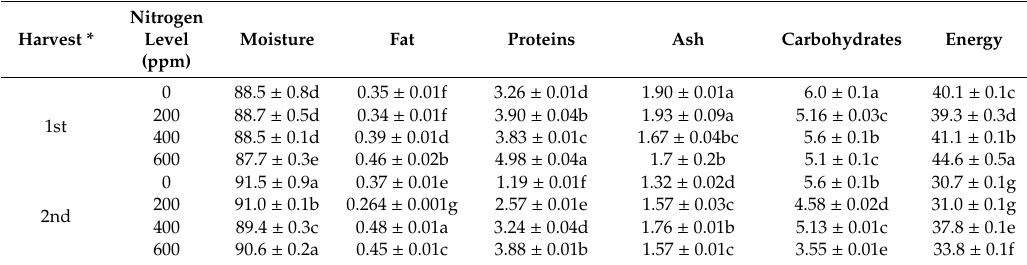
Table 2. Nutritional value (g / 100 g fw) and energetic value (kcal / 100 g fw) of Centaurea raphanina subsp. mixta plants grown in 2 L pots under greenhouse conditions, in relation to harvesting time (1st and 2nd harvest) and nitrogen level (0–600 ppm) (mean ± SD; n =